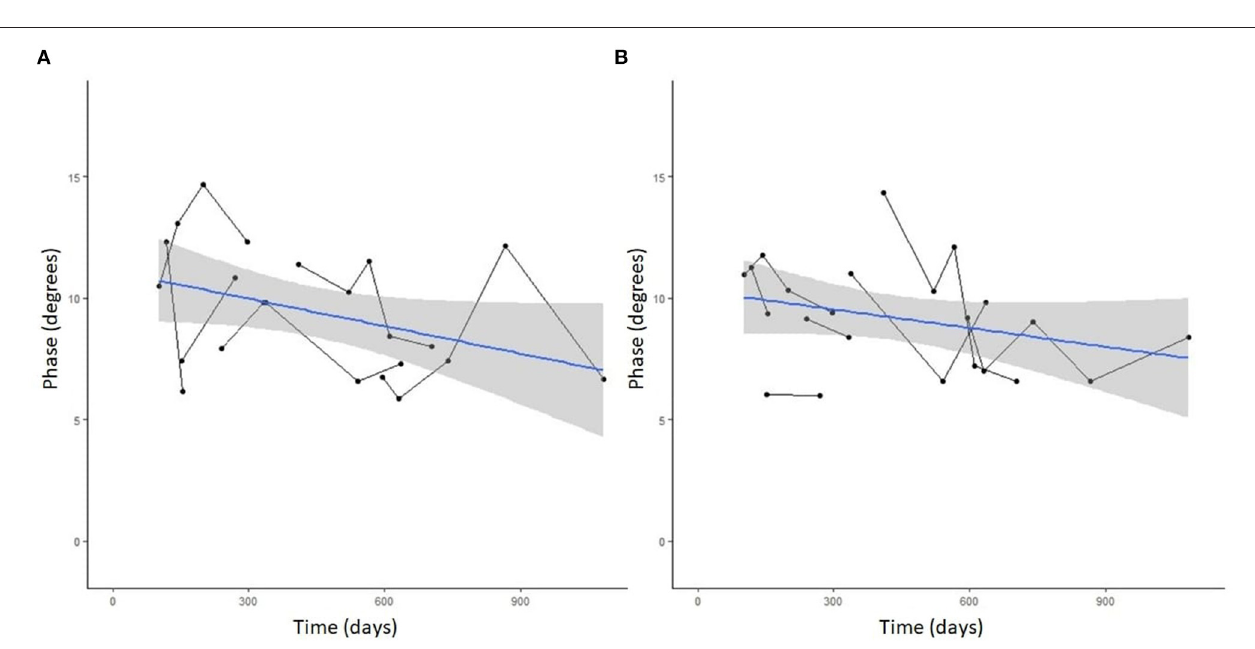
FIGURE 5 | Spaghetti plot highlighting mean EIM phase changes across all muscles in the (A) left and (B) right pelvic limbs in serially monitored dogs with DM. The time in days is measured from the onset of clinical signs attributable to DM. Muscles included in means are the gastrocnemius, craniotibialis, biceps femoris, gracilis, and